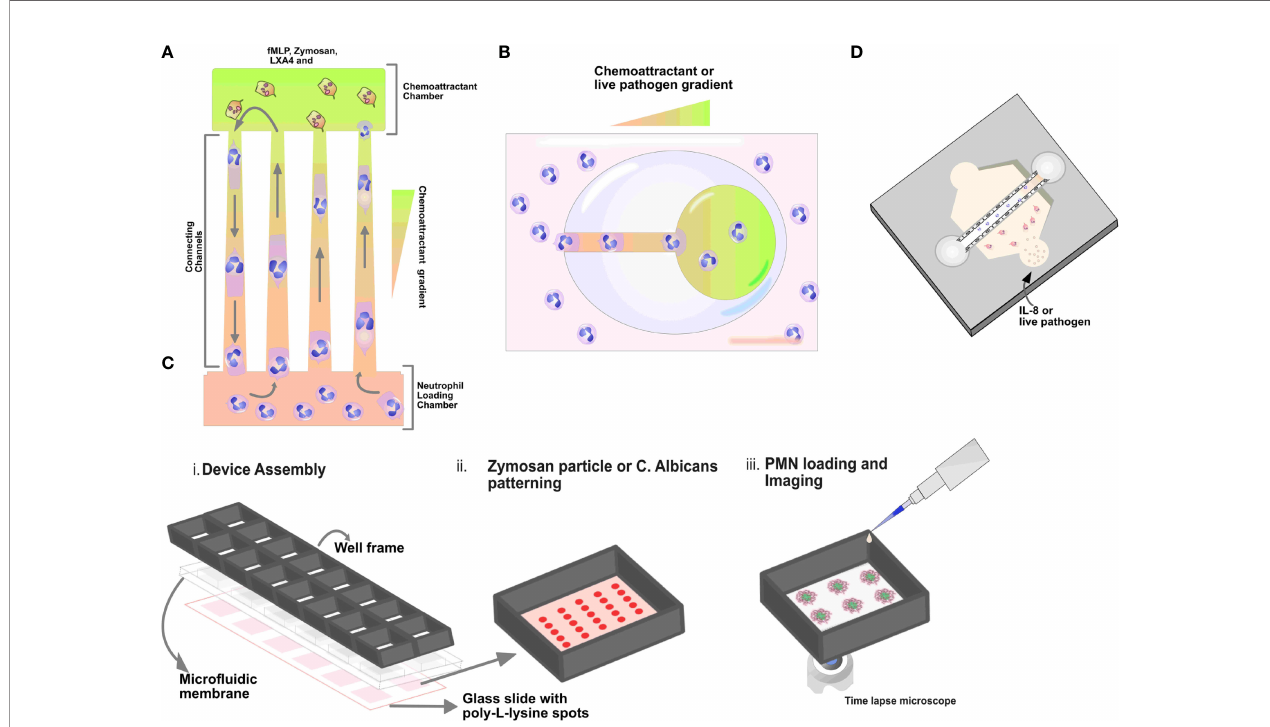
FIGURE 2 | Schematics of micro fl uidic devices. (A) Tapered channel showing neutrophils migrating from the cell loading chamber (bottom) to the chambers loaded with chemoattractant fMLP (top). (B) Schematic illustration of egg-shaped chip. It consists of an inner chemoattractant micro-chamber and a large egg-shaped chamber connected by a straight channel. Neutrophils are seen migrating towards fMLP gradient in the egg chip shaped device. (C) Micropatterned C. albicans or zymosan particles (red spots) array for the quanti fi cation of neutrophil swarming i) Schematic illustrations showing the assembly of the 16 well open chamber device, ii) zoom ‐ in of one of the zymosan particle patterning in the wells and iii) subsequent neutrophil cells loading and imaging (D) Organotypic micro fl uidic devices include a model vasculature containing endothelial cells in a relevant lumen geometry. These devices use both chemokines and live pathogens to induce